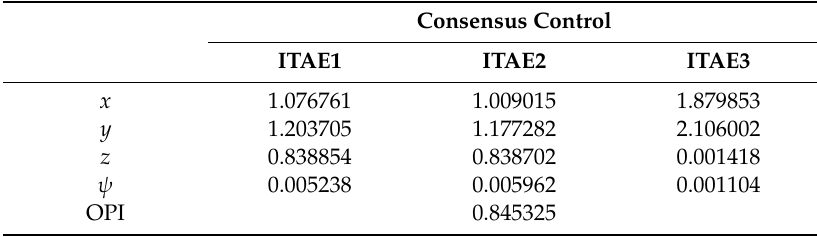
Table 8. Performance indices and OPI values for consensus control.